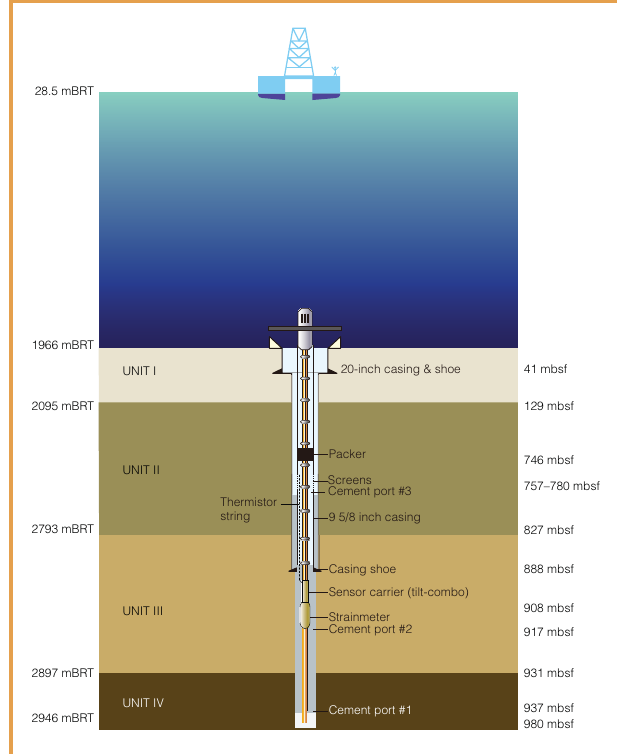
Figure 3. Diagram of the LTBMS installed at Site C0002. The lithological units (Units I–IV) are shown, as well as the depths for different components of the observatory and casing string. Lithological Unit IV is the upper accretionary prism, while Units III to I represents the Kumano forearc basin. (mBRT=meters below rotary table; mbsf=meters below